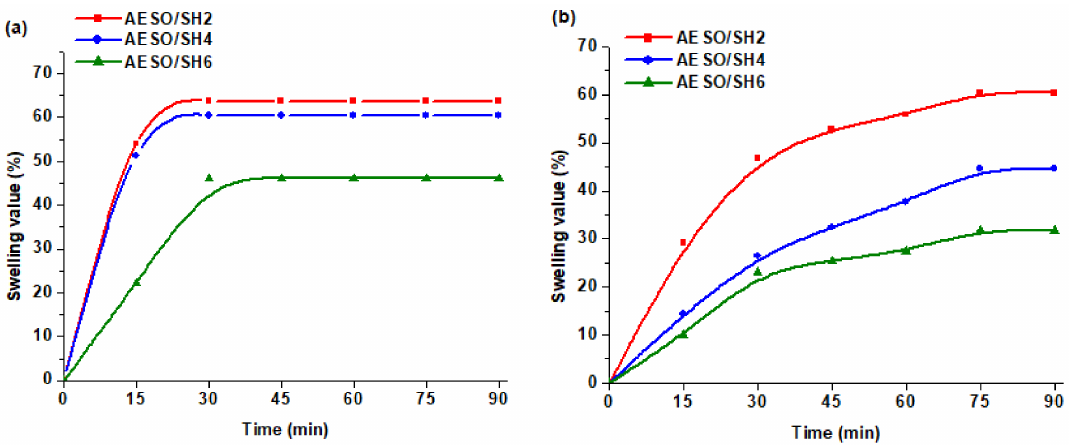
Figure 7. Swelling values: ( a ) in chloroform; ( b ) in toluene at 18 ◦ C versus times curves of cross-linked